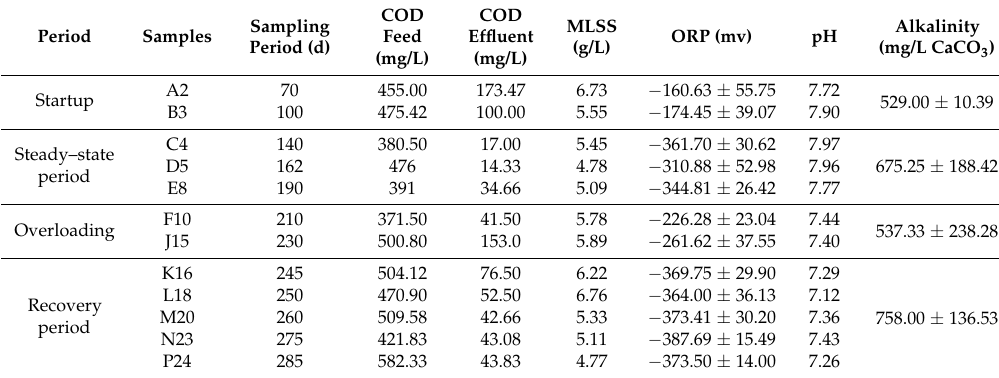
Table 1. Operational and environmental